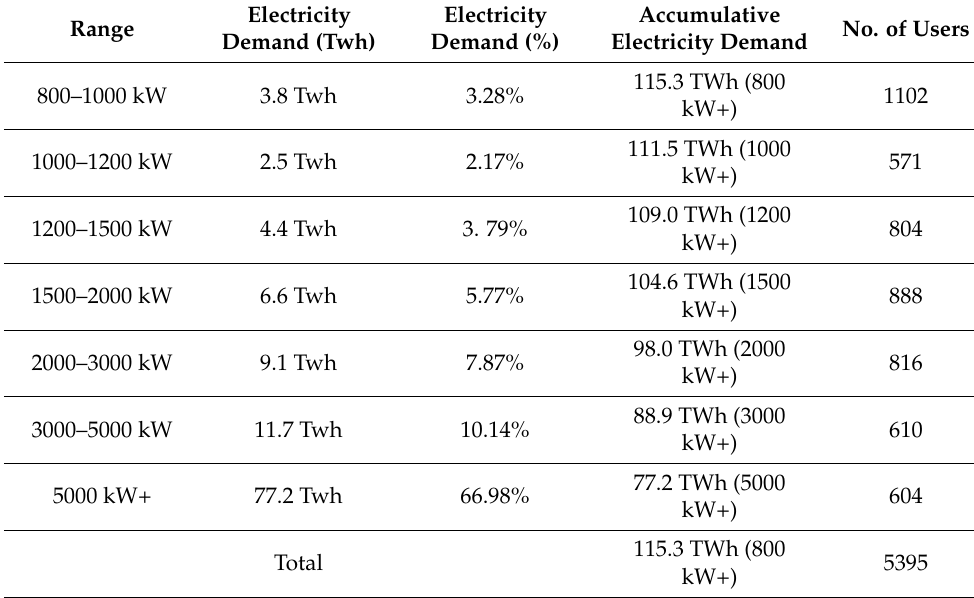
Table 3. The 800 kW+ electricity